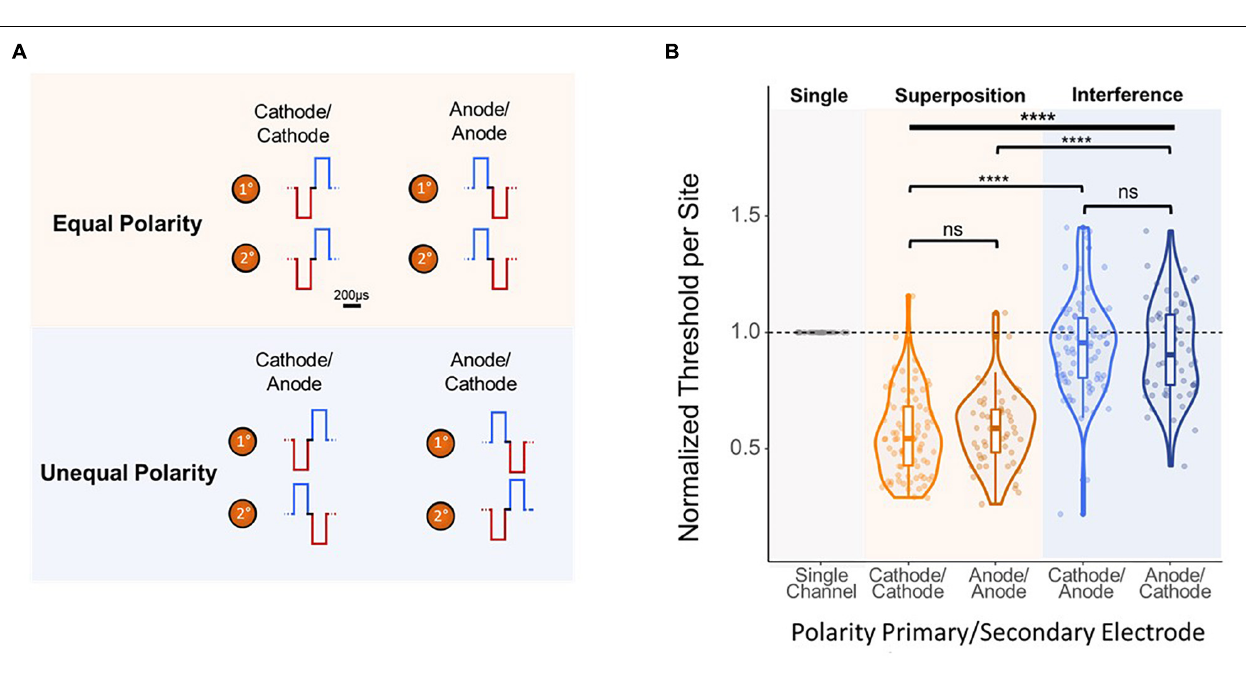
Frontiers in Neuroscience |